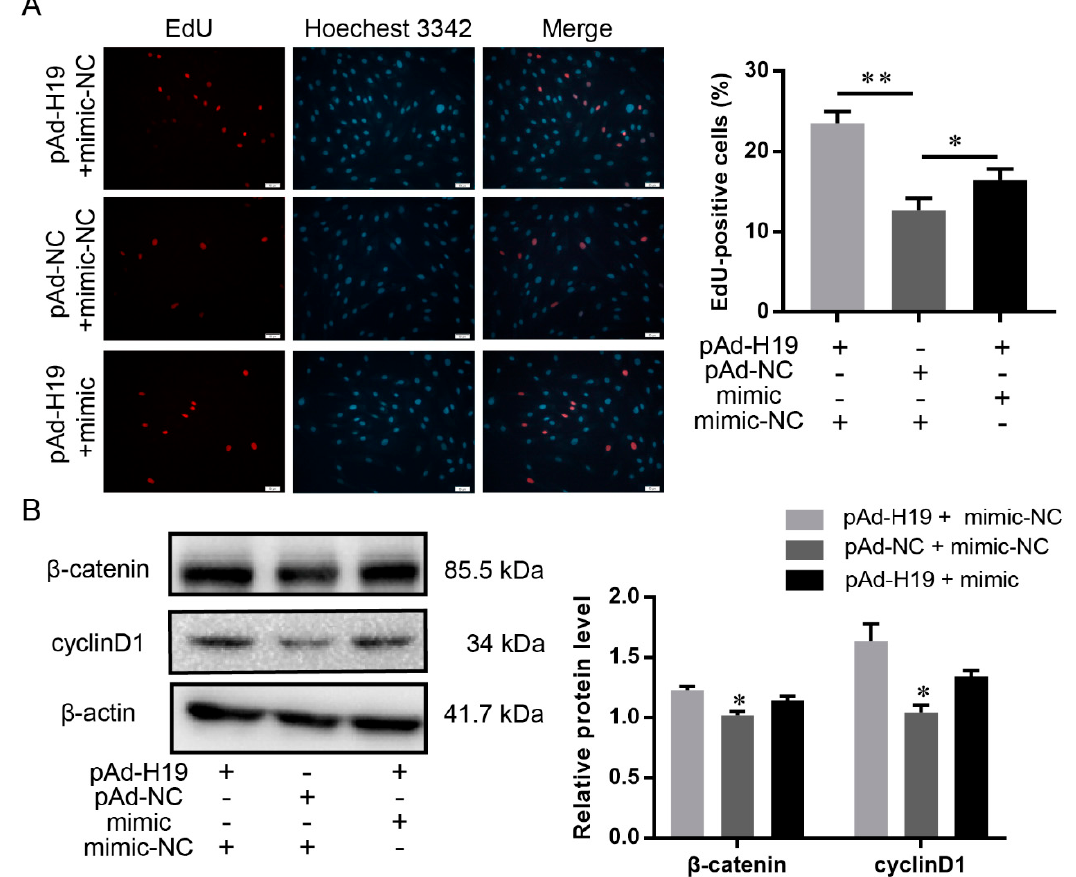
Figure 6. chi-miR-214-3p weakened the positive effect of H19 on dermal papilla cell proliferation.